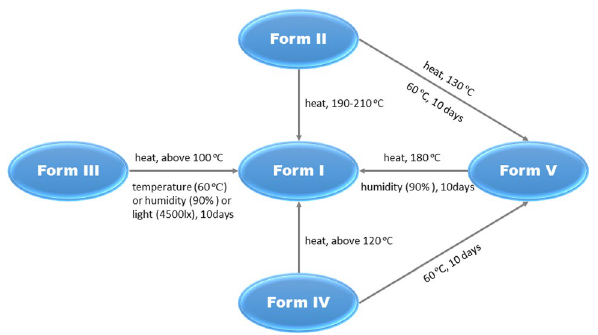
Fig. 12 The transformation of mangiferin forms